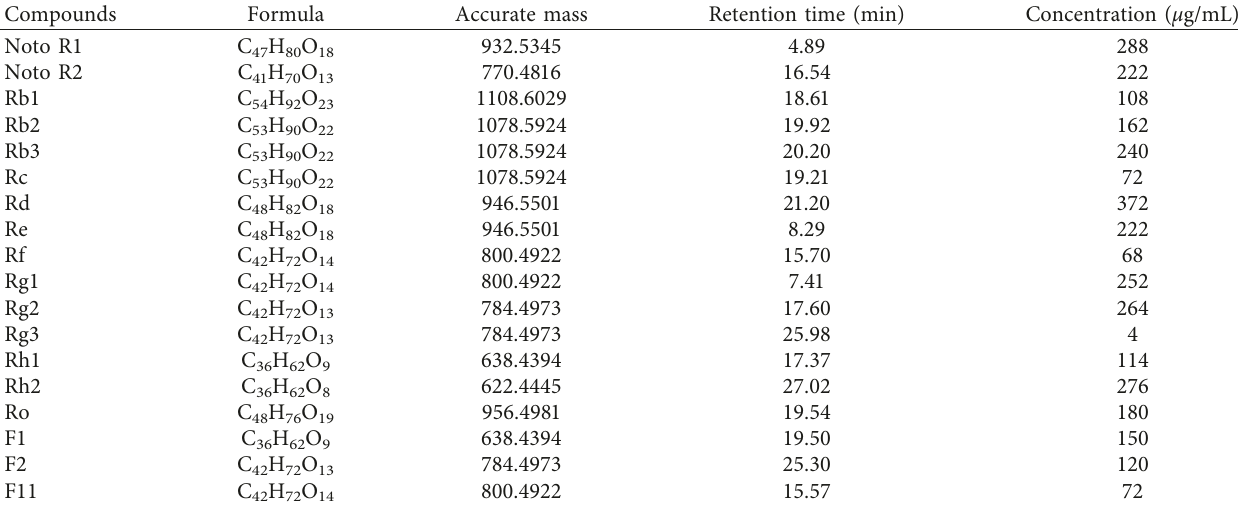
Table 1: Chemical information of the eighteen ginsenoside standards.